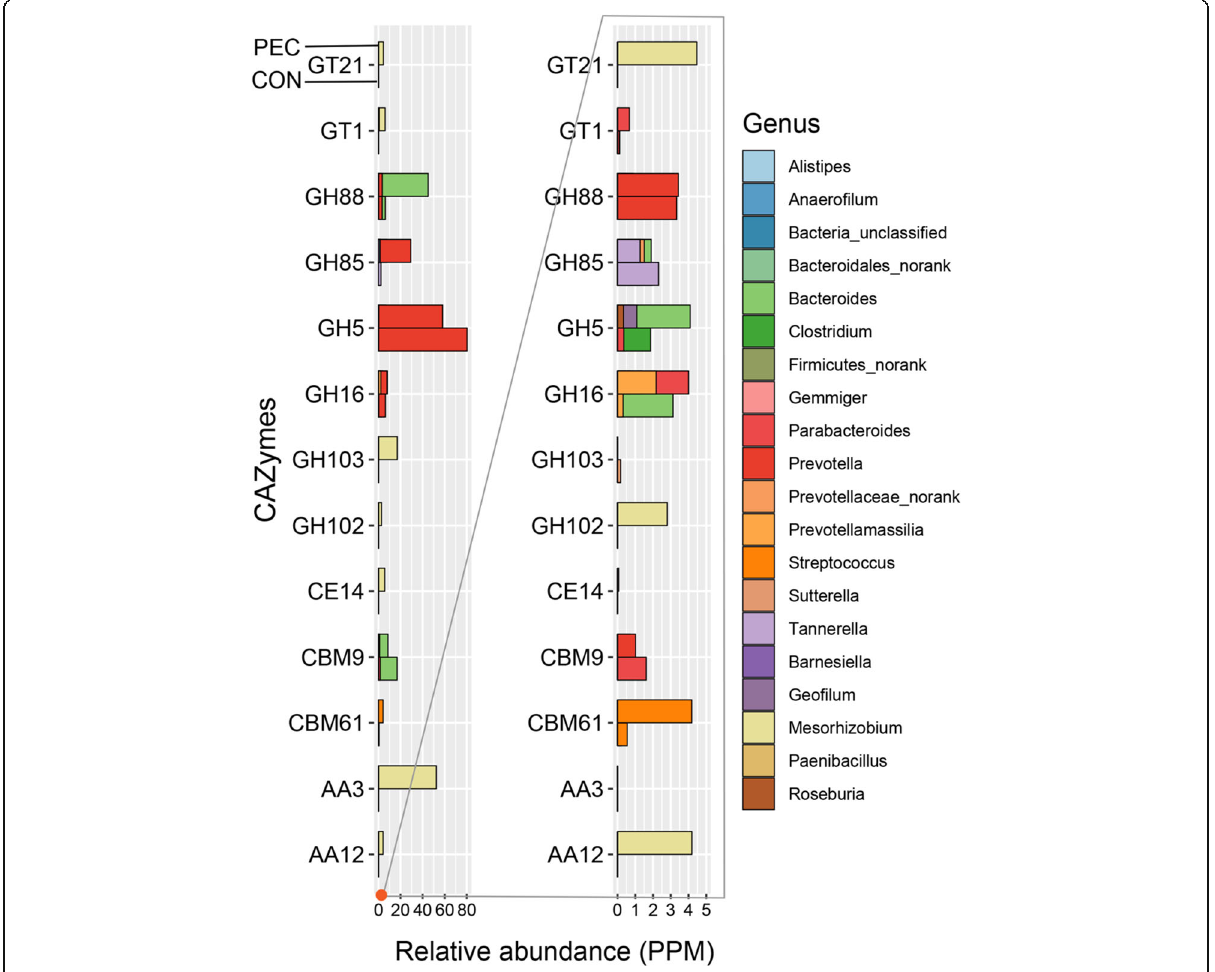
Fig. 9 Contributions of CAZymes from the major microbial communities in the growing pigs ’ colons (PEC vs. CON). The graphs show the abundance of the top 15 genera that constitute the major contributors of CAZymes to the growing pig colon ecosystem. AA, auxiliary activities; CBM, carbohydrate-binding modules; CE, carbohydrate esterases; GH, glycoside hydrolases; GT, glycosyl transferases. PEC, pectin-enriched diet; CON, control